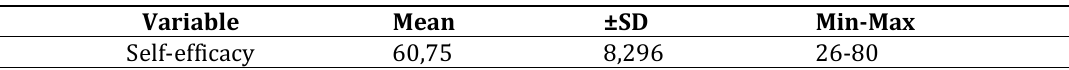
Self-efficacy scores for nursing professional education students at the Faculty of Nursing, Jember University (n = 236 respondents)